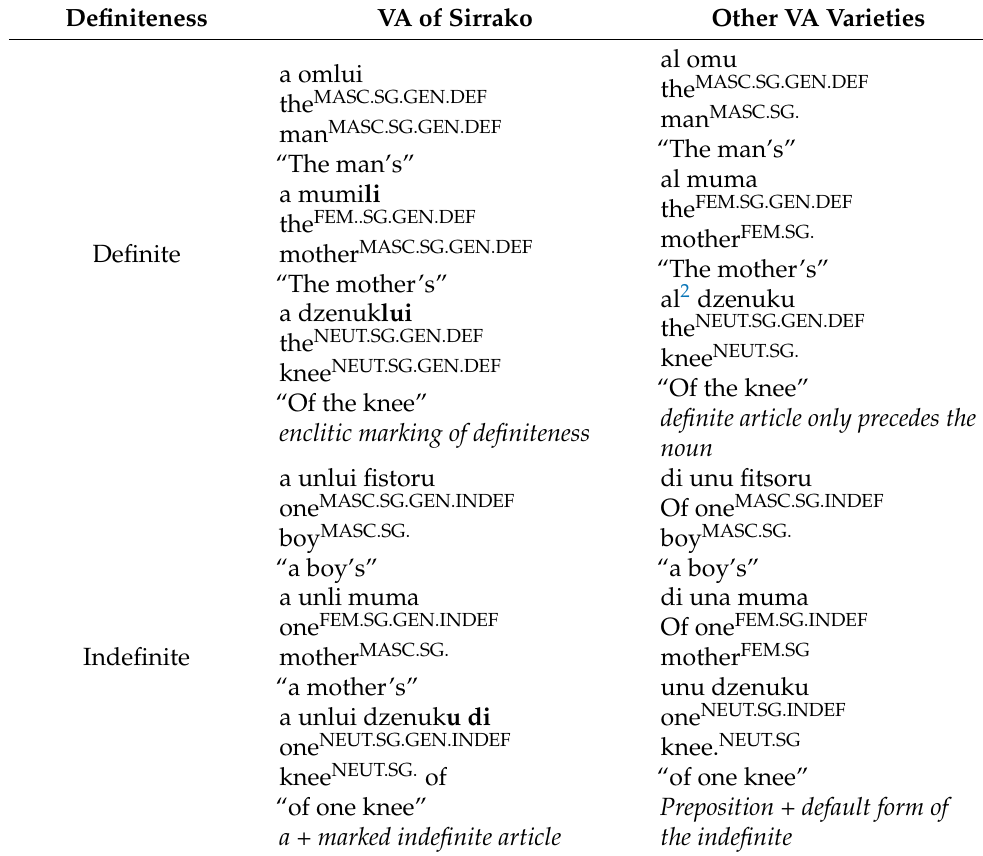
Table 6. Variation in definiteness marking in